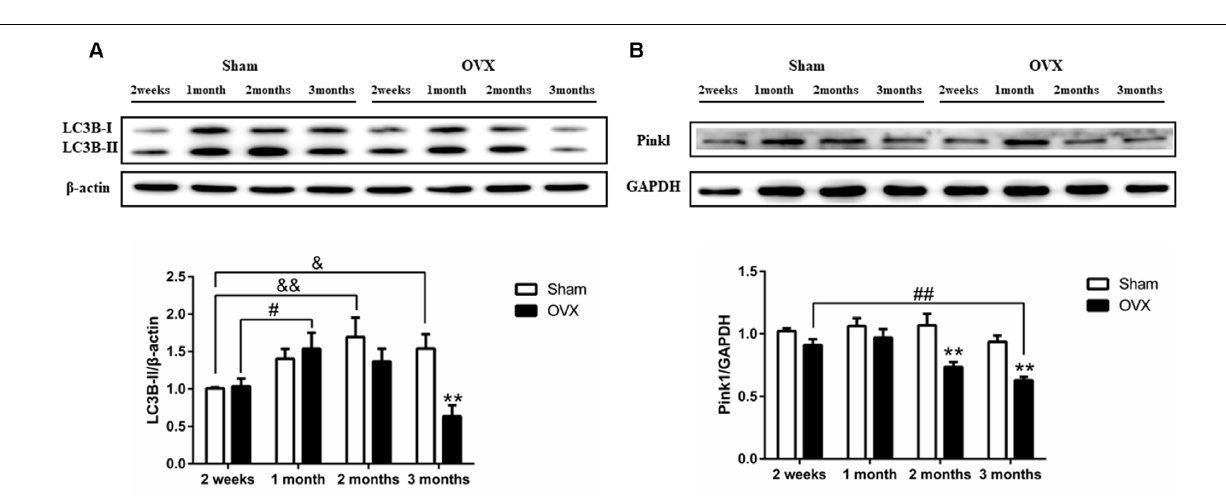
FIGURE 7 | Levels of the autophagy and mitophagy proteins (A) LC3B-II and (B) Pink1 in the hippocampus of mice after sham surgery (Sham) or ovariectomy (OVX). Bars represent mean values ± standard error of the mean (SEM). ∗∗ p < 0.01 compared with the Sham mice at the same timepoint; & p < 0.05, && p < 0.01 compared with the 2 weeks Sham mice; # p < 0.05, ## p < 0.01 compared with the 2 weeks OVX mice ( n =